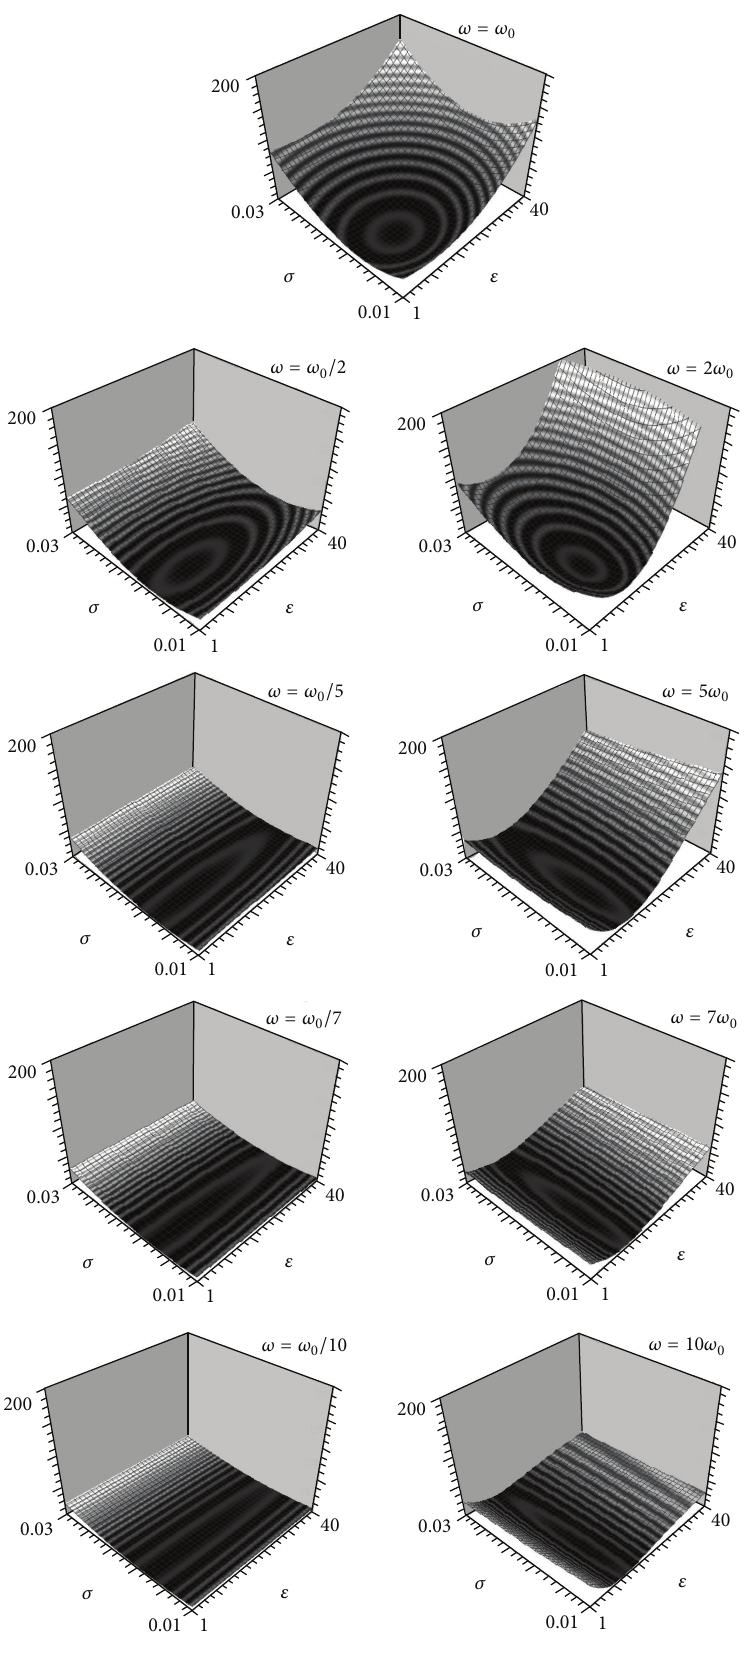
Figure 1: The behavior of Δ 𝜔 for various values 𝜔